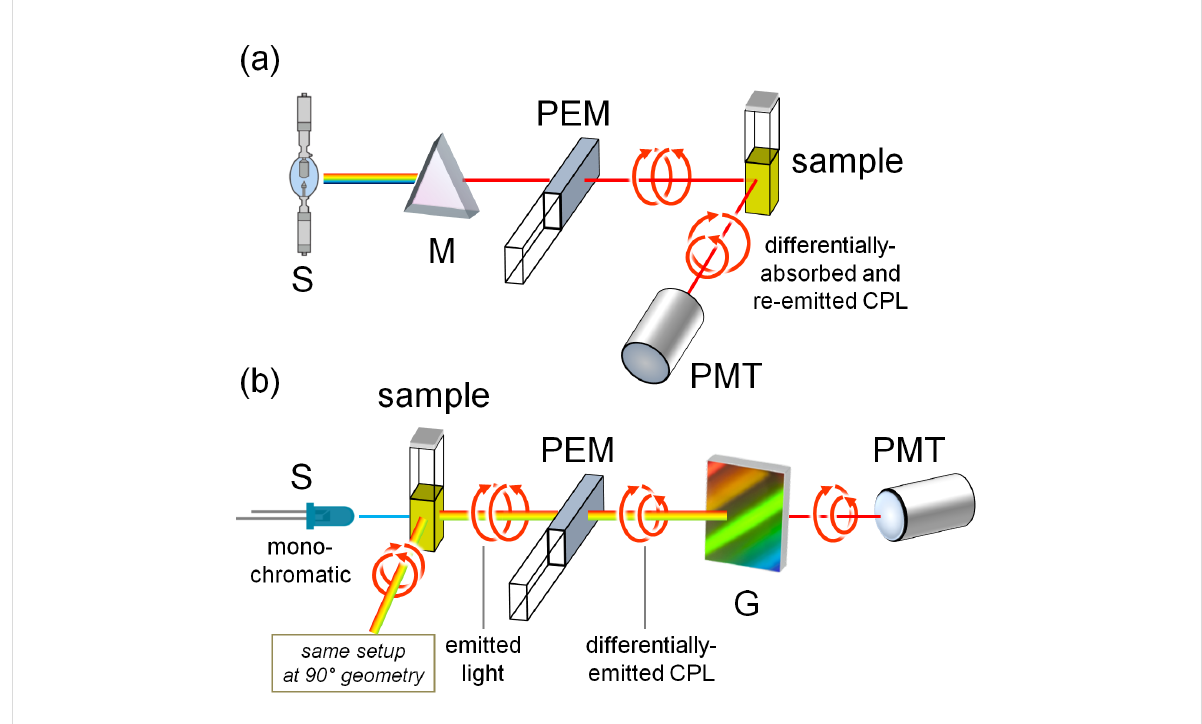
Figure 11: Schematic illustration of an FDCD a) and a CPL b) instrument. Legend: S, source; M, monochromator (excitation wavelength selector); G, diffraction grating (emission wavelength selector); PEM, photoelastic modulator; PMT, photomultiplier (detector). In CPL, both 0° and 90° setups are possible; in FDCD, the 90° setup is